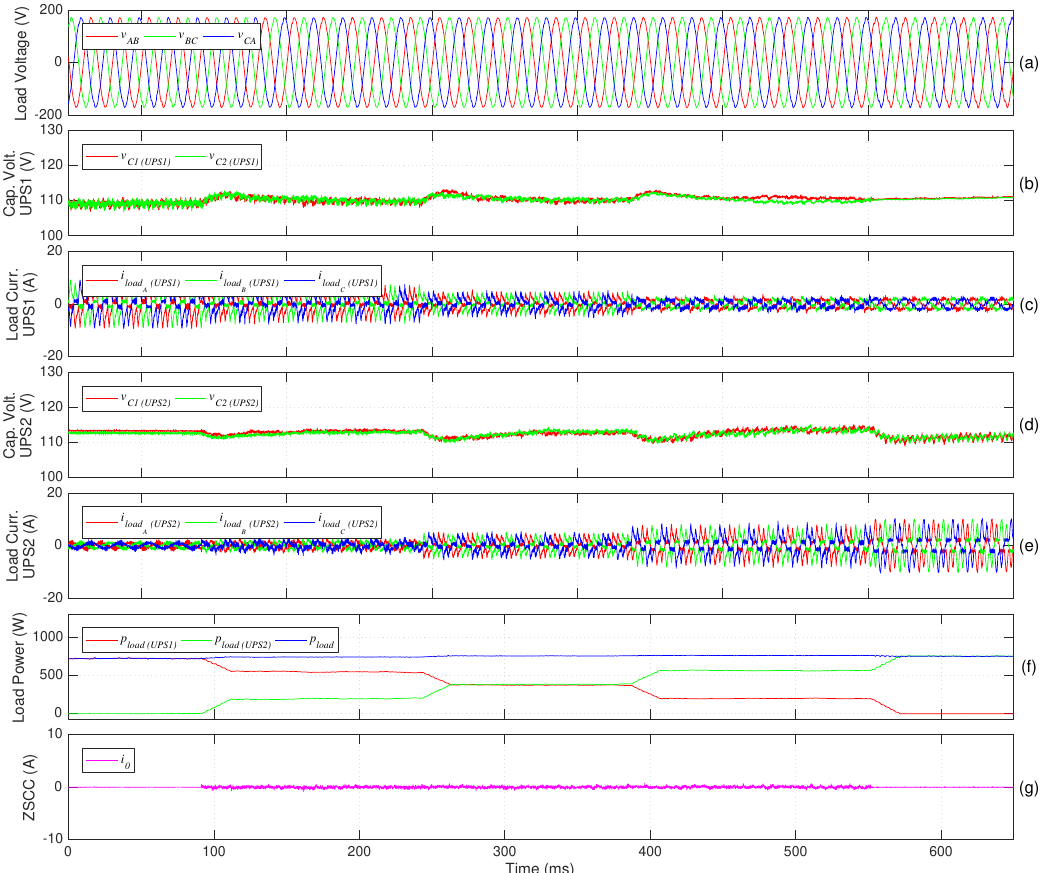
Figure 11. System performance when different percentage of the load power is assigned to each UPS: ( a ) Load Voltage; ( b ) DC bus capacitors voltage of UPS1; ( c ) UPS1 load current; ( d ) DC bus capacitors voltage of UPS2; ( e ) UPS2 load current; ( f ) Load power distribution and total load power; ( g ) Zero Sequence Circulating